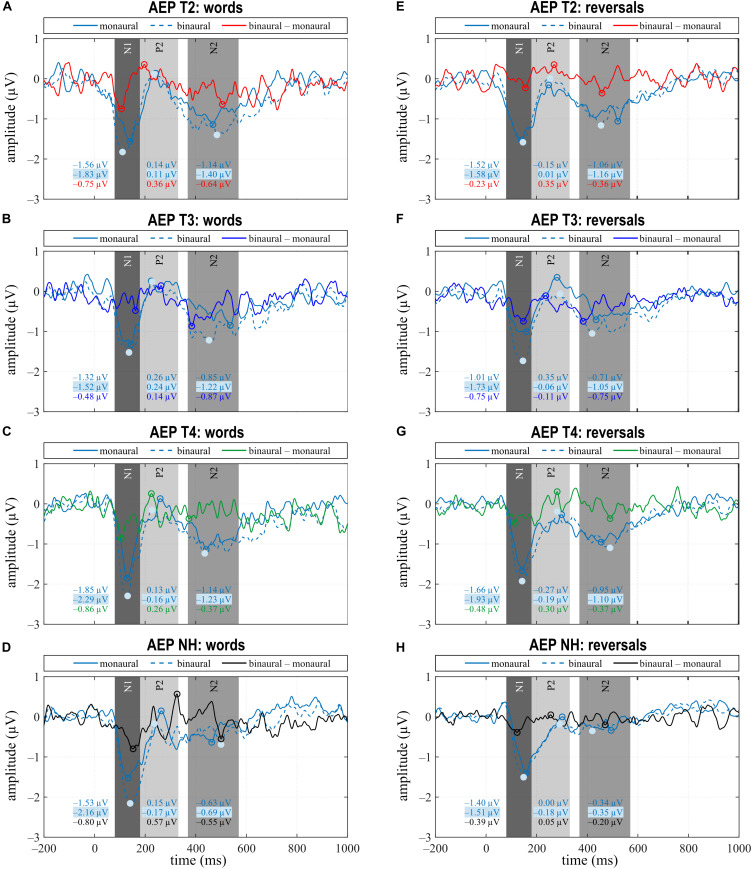
Grand averages for monaural, binaural listening conditions, and the difference binaural – monaural for the categories “words” (A–D) and “reversals” (E–H) of the CI (T2–T4) and NH group. (A–H) Time intervals with N1, P2, and N2 responses are shaded in different grays.